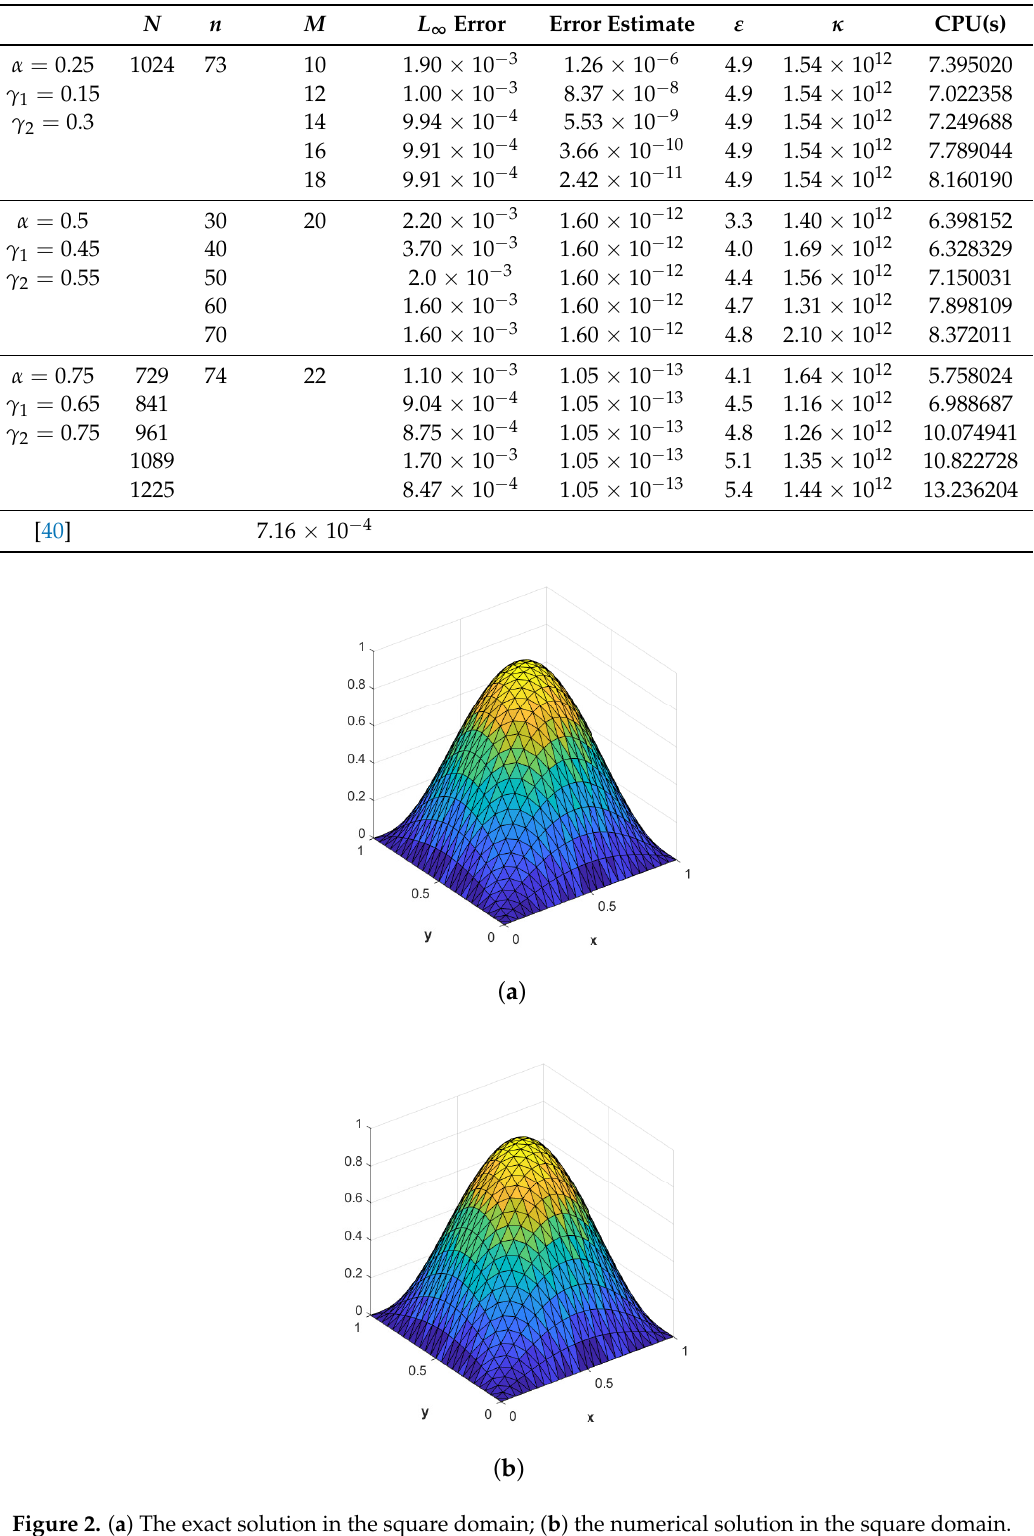
Figure 2. ( a ) The exact solution in the square domain; ( b ) the numerical solution in the square